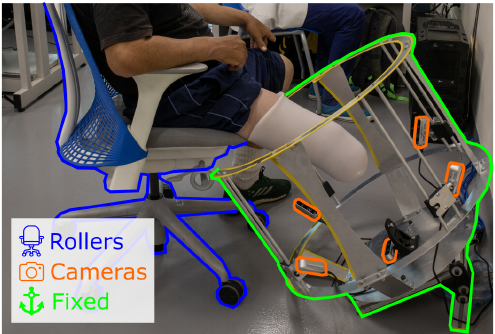
Figure 5. Example of the participant’s and operator’s interaction with the system, with a non-contact scheme. Labeled in blue, the rolling chair enables the participant to move towards the frame. In orange, previously calibrated cameras aiming at the residual limb. In green, the fixed structure, with a C shape at the top for ease of